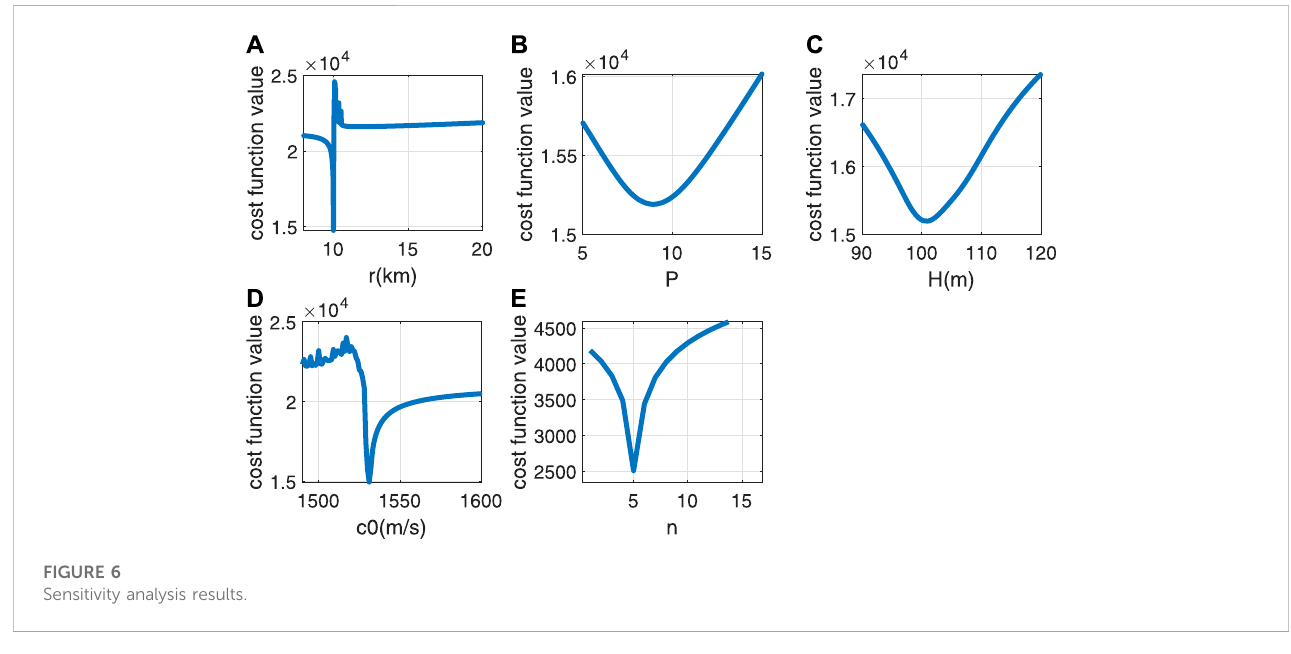
FIGURE 6 Sensitivity analysis